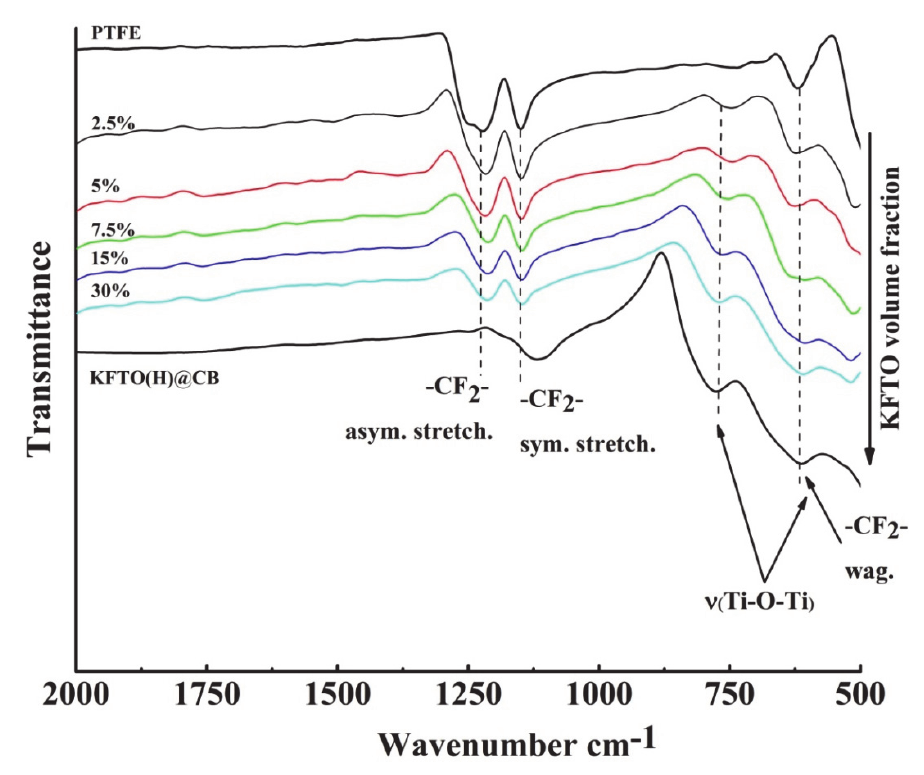
Figure 4. FTIR spectra of PTFE, KFTO(H)@CB, and polymer matrix composites based on them. Scanning electron microscopy (SEM) images of a fractured cross-section of PTFE/KFTO(H)@CB composites with 30 vol.% ceramic filler in the polymer matrix are shown in Figure 5a,b. KFTO(H)@CB filler particles with dimensions less than 1 µ m